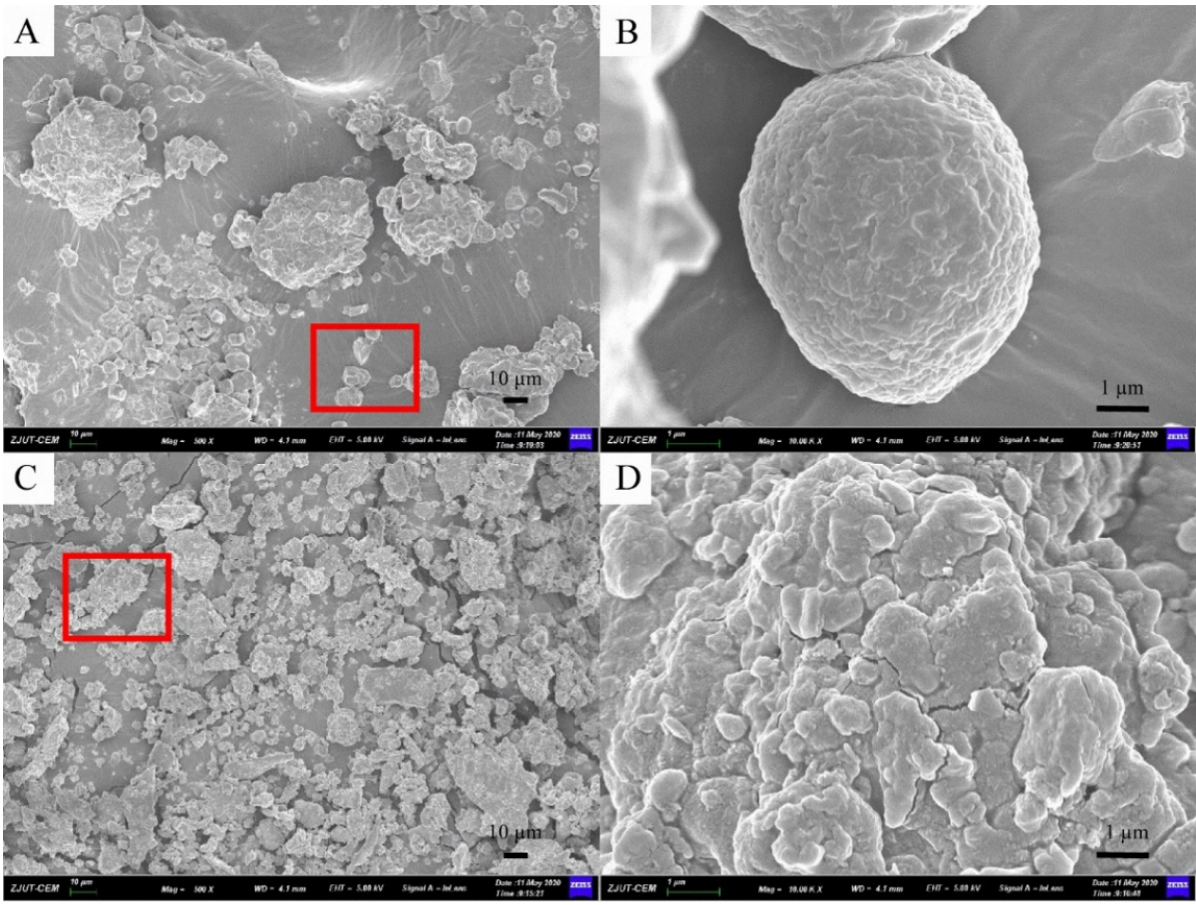
Figure 3. The SEM micrograph of: ( A ) sea buckthorn powder of raw material (500×); ( B ) figure of red area in A (10.00K×); ( C ) milled with Na 2 CO 3 for 20 min (500×); ( D ) figure of red area in ( C ) (10.00K×).